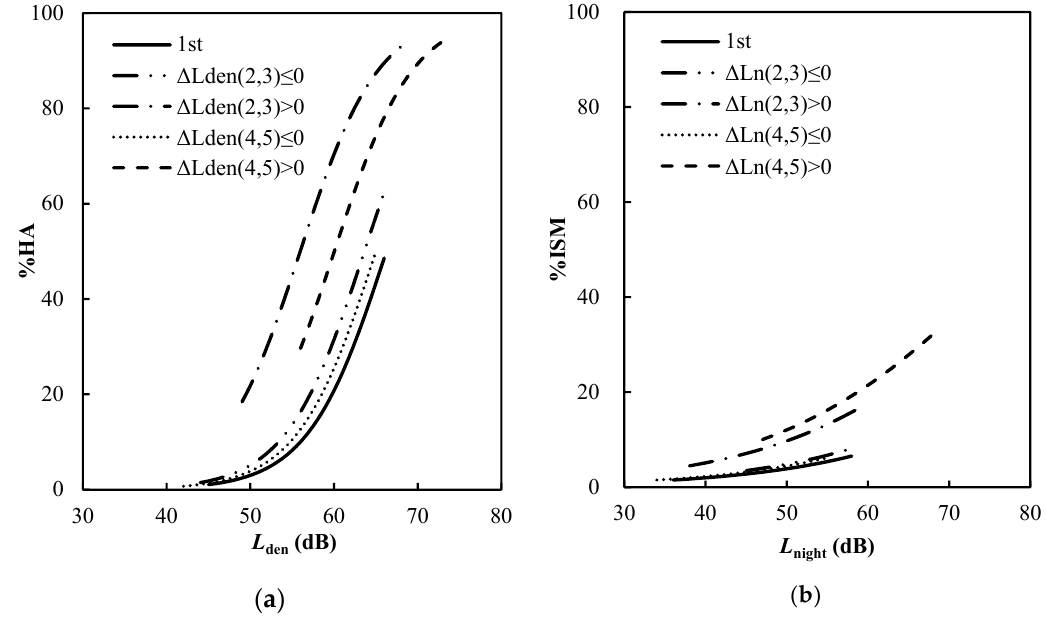
Figure 3. Comparison of ( a ) Lden–% HA and ( b ) Lnigh–% ISM relationships adjusted by modifying factors in the 1st survey (reference curve) and sites classified with ∆ Lden and ∆ Lnight; non-acoustic variables including sex, age, noise sensitivity, length of residence, floor area and sound insulation; and interaction of noise sensitivity and Lden ( a ) and Lnight ( b ). The numbers in the parentheses